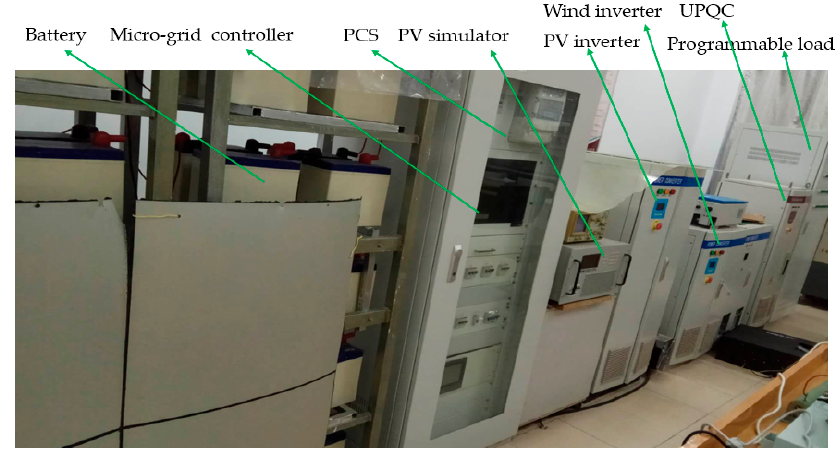
Figure 15. Micro-grid platform.